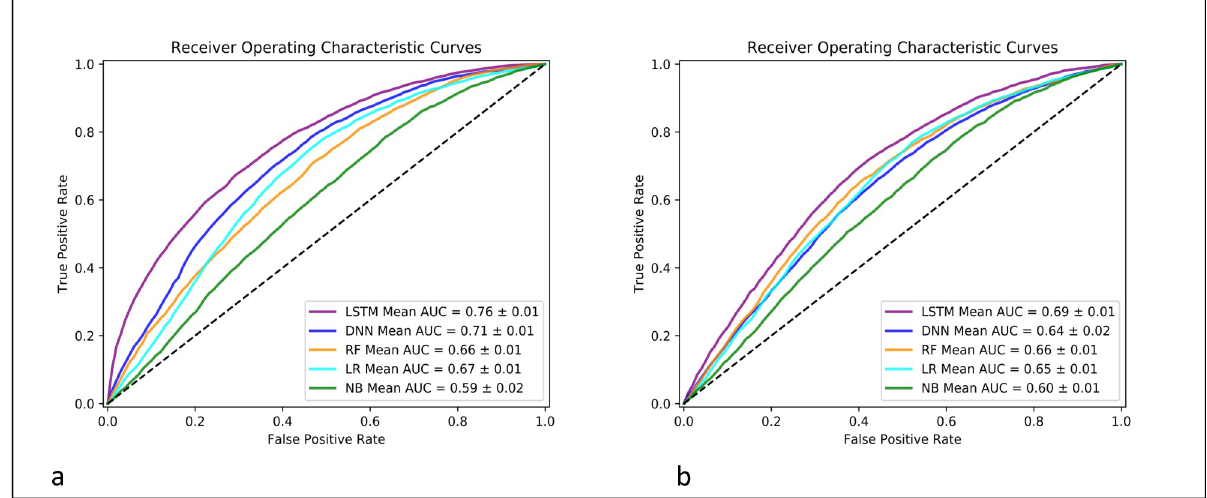
Fig 4. CD prediction performance by area under the curve (AUC) for LSTM, DNN, RF, LR, and NB models. LSTM–long short-term memory; RF– random forest; NB–na ï ve Bayes.